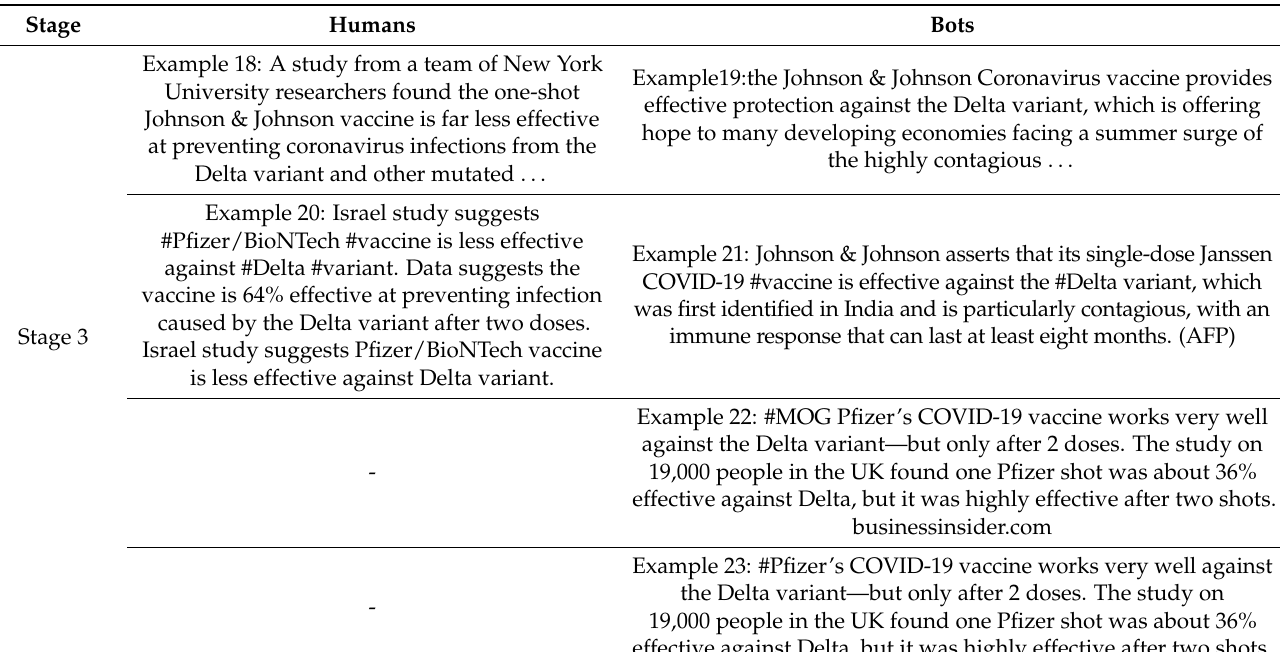
Table 5. Typical Tweets—Examples of Social Bots and Human Users at Stage